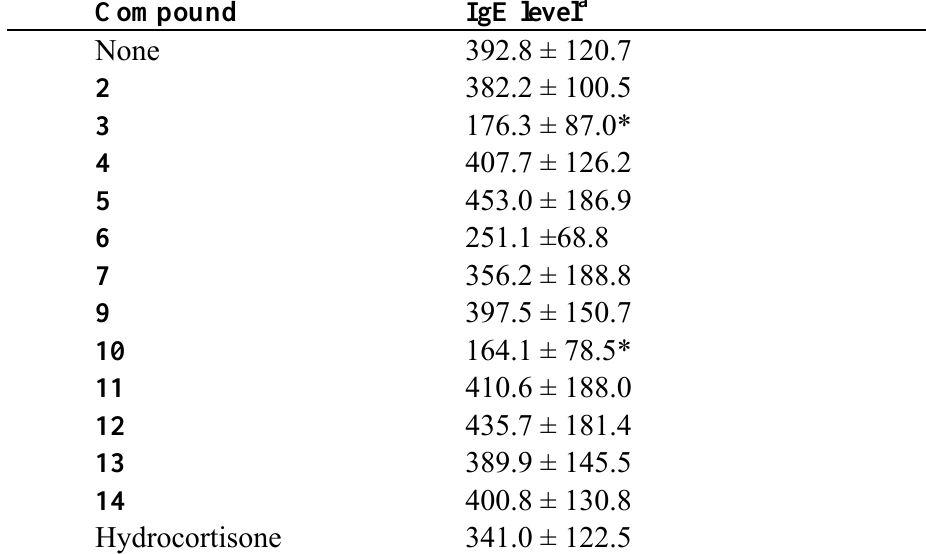
Table 1. Suppressive action of β -glycosides of glycitein and daidzein 2 - 7 and 9 - 14 on IgE antibody